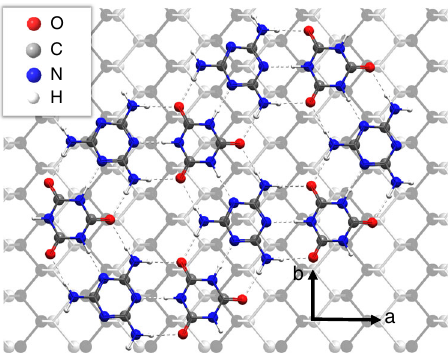
Fig. 4 Diagram showing the relative orientation of melamine cyanurate on the surface of black phosphorus. Vectors a and b show orientation of the substrate